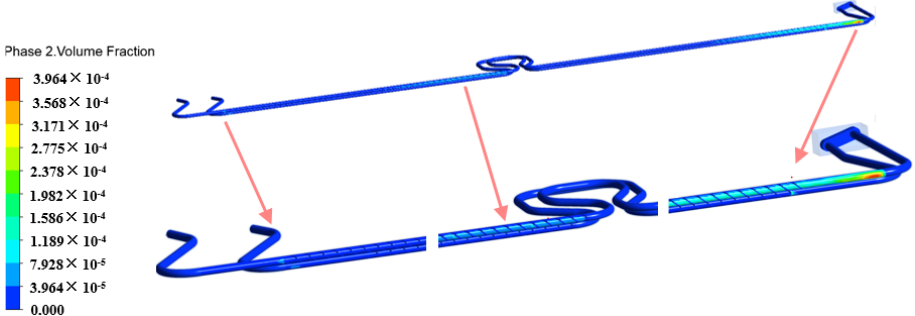
Figure 8. Distribution of void fraction inside the swirl tube under one-side heating.